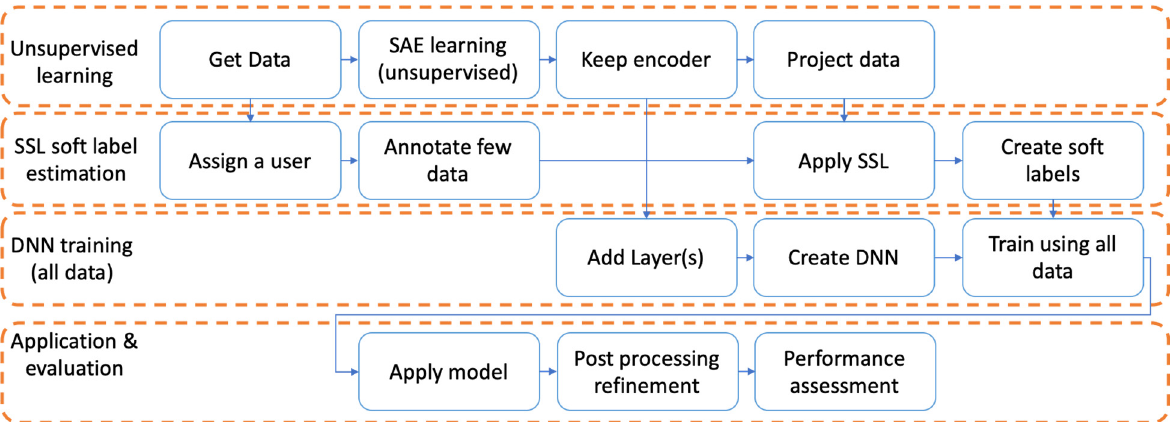
Figure 2. A graphical representation of the main steps of our SAE-driven SSL-based methodology.